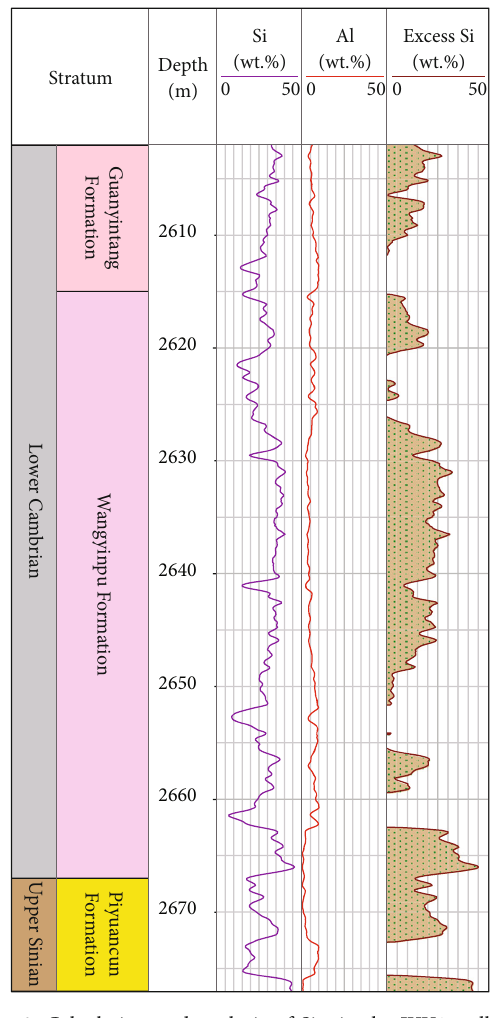
in the JXY1 well in the ex